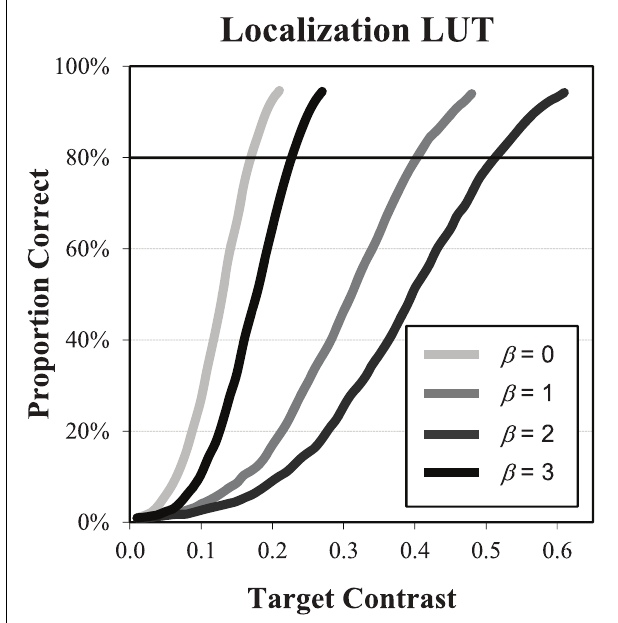
FIGURE 4 | Ideal observer LUT. The plots show performance of the ideal observer as a function of target contrast for each of the power-law exponents. These data can be used as a look-up-table for determining the threshold contrast needed by the IO to achieve a given level of performance. For example, at β = 1, the threshold contrast needed to achieve 80% correct is seen to be